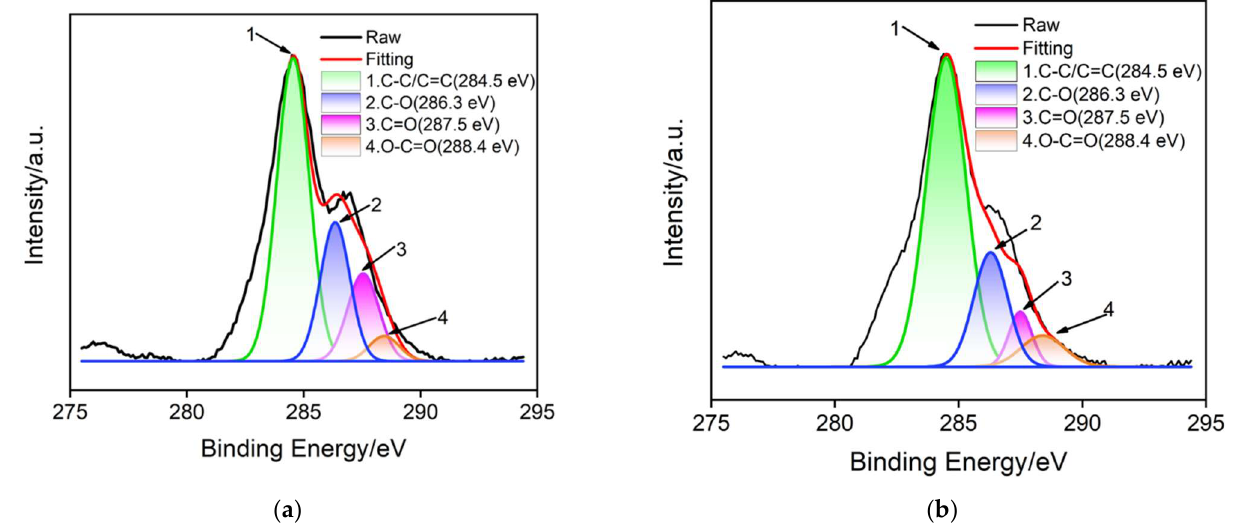
Figure 4. High-resolution C 1 s XPS spectra of GO/SPCE ( a ) or ErGO/SPCE ( b ) electrode.